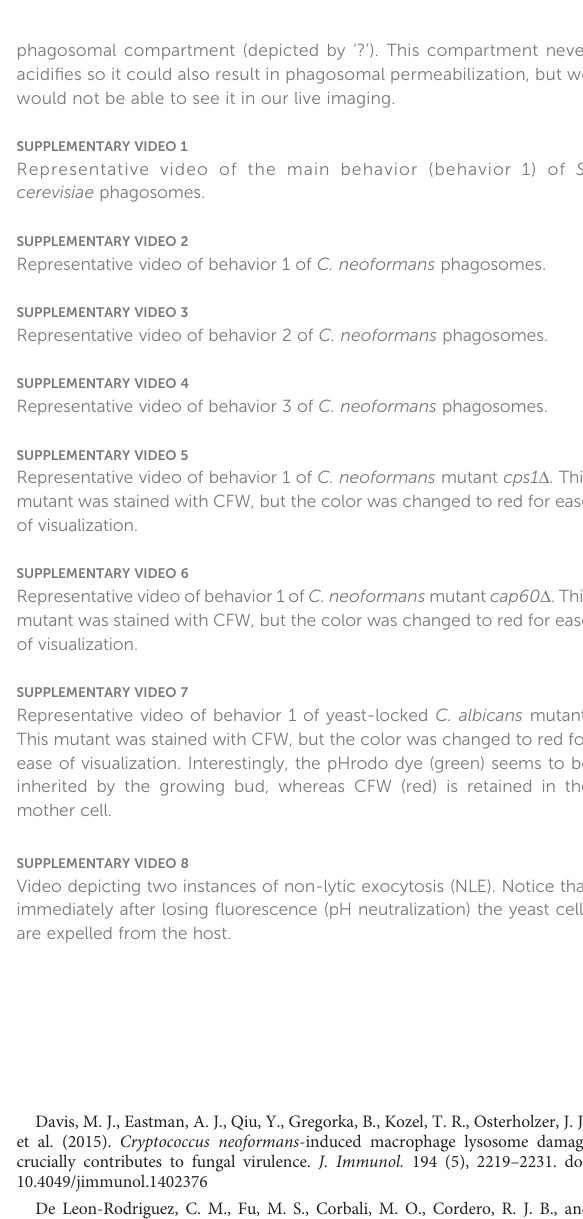
SUPPLEMENTARY FIGURE 2 Polarization of THP-1 cells using IFN g or IL-4 treatment. THP-1 cells were